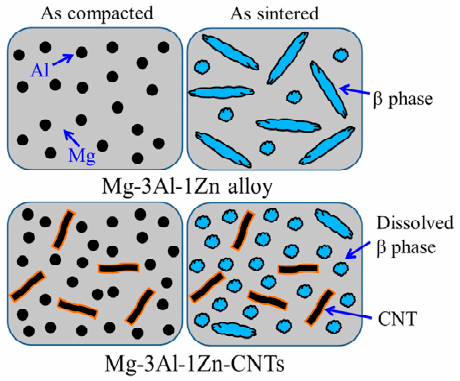
Figure 23. A schematic view of Mg 17 Al 12 particles formed in Mg-3Al-1Zn/MWNTs nanocomposites prepared by powder metallurgy method. The incorporation of MWNTs can drastically refine the particles ( β phase corresponds to Mg 17 Al 12 ) [146]. (Reproduced with permission from [146], Elsevier, 2015.)